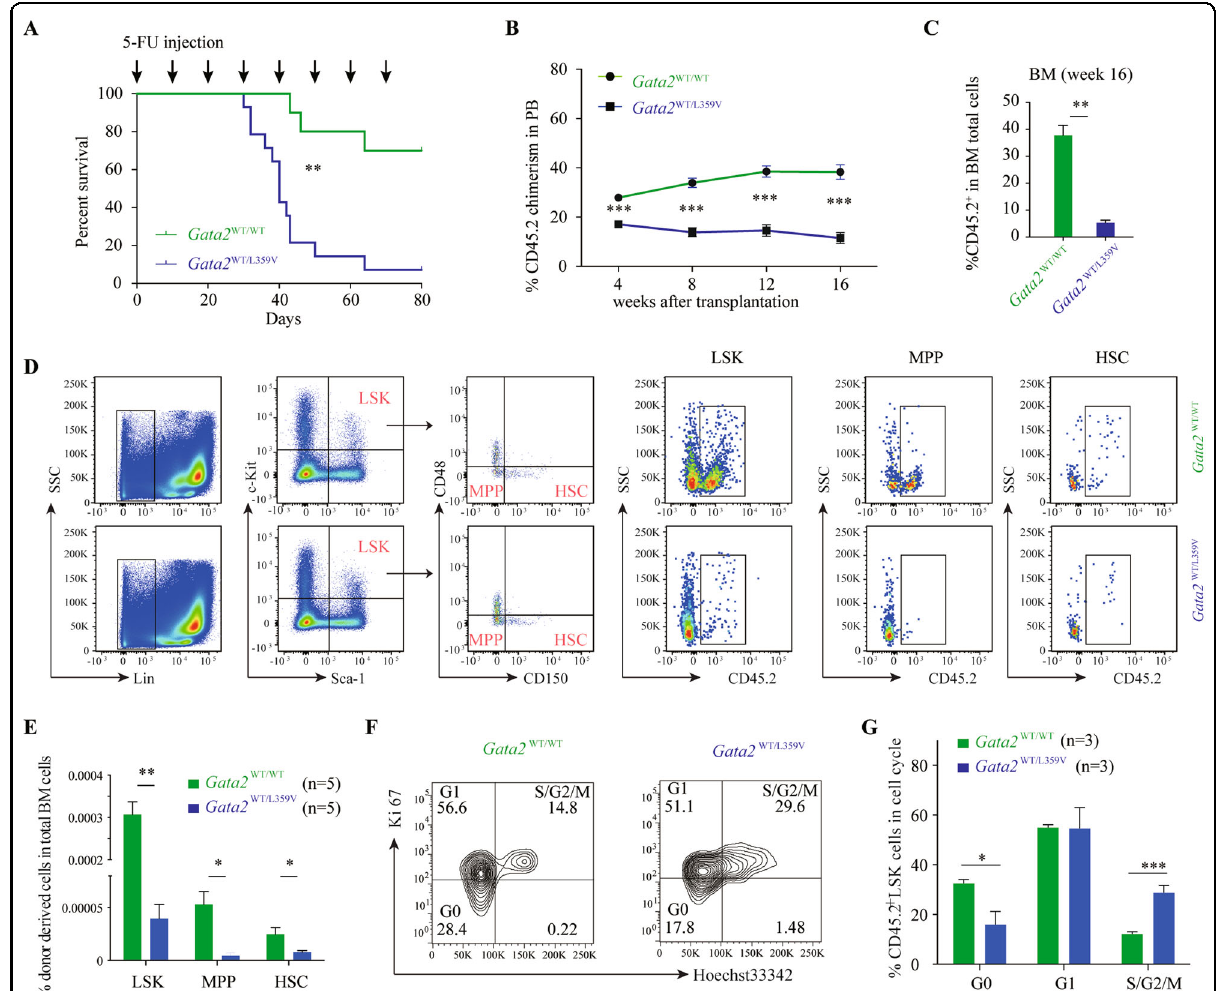
Fig. 3 Impairment of de fi nitive hematopoiesis in Gata2 WT/L359V mice. A Survival analysis of Gata2 WT/WT ( n = 15) and Gata2 WT/L359V mice with 5- FU intraperitoneal injection. The 6 – 8-weeks-old Gata2 WT/WT ( n = 15) and Gata2 WT/L359V ( n = 15) mice were treated with 150 mg/kg 5-FU every 10 days until all the mice in one group die ( p < 0.01, Kaplan – Meier analysis). B HSC reconstitution capacity analysis by competitive bone marrow (BM) transplantation. The reconstitution in recipient mice was followed for 16 weeks, and the percentages of CD45.2 + peripheral blood mononuclear cells (PBMCs) derived from Gata2 WT/WT ( n = 19) and Gata2 WT/L359V ( n = 17) donors were analyzed every 4 weeks (Student ’ s t test). C Statistical analysis of the percentage of CD45.2 + cells in the total BM cells between Gata2 WT/L359V ( n = 5) and Gata2 WT/WT ( n = 5) groups (Student ’ s t test) at 16 weeks after reconstitution. D Gata2 WT/L359V interfered with HSC self-renewal in competitive BM transplantation. Representative display of fl ow cytometry analysis was shown. The LSKs (Lin - c-Kit + Sca1 + ), MPPs (Multipotent progenitors, CD48 − CD150 − LSK), and hematopoietic stem cell (HSCs, CD48 - CD150 + LSK) were gated. The percentage of donor-derived cells (CD45.2 + ) were then examined. E Comparison of the percentage of donor-derived LSK, MPP, and HSC in reconstituted BM cells between Gata2 WT/L359V ( n = 5) and Gata2 WT/WT ( n = 5) groups (Student ’ s t test). F Representative display of cell cycle of LSKs from competitive BM transplants. BM cells were harvested at week-16 post-reconstitution and stained with Ki67 and Hochest33342. G Comparison of the cell cycle between Gata2 WT/L359V ( n = 5) and Gata2 WT/WT ( n = 5) groups (Student ’ s t test). Error bars represent the deviation from the average, and signi fi cant differences are indicated by * p < 0.05, ** p < 0.01, and *** p <